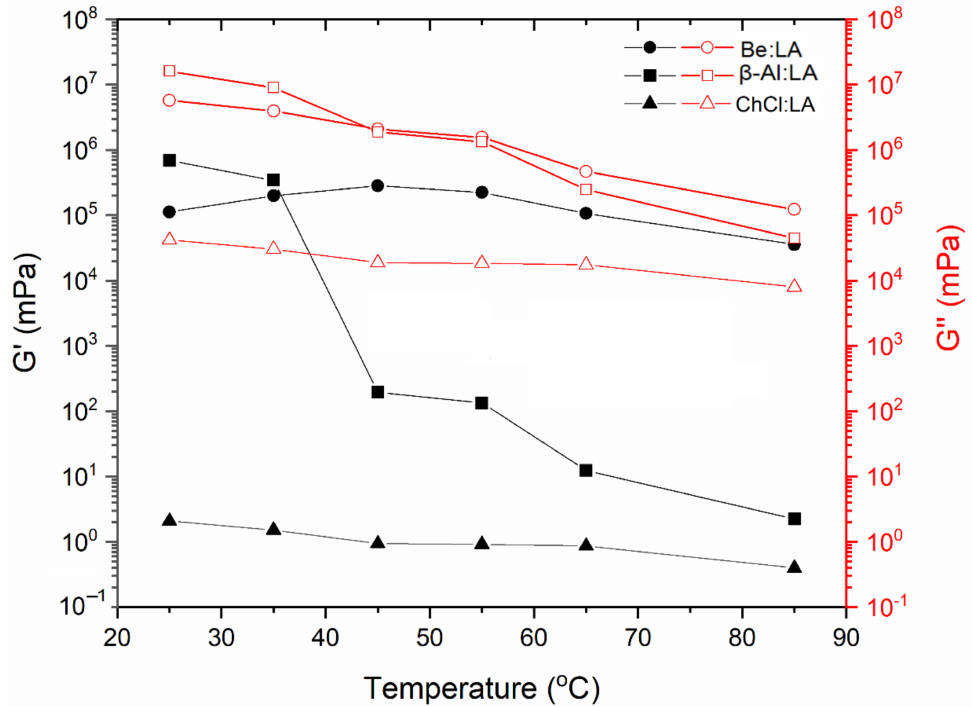
Figure 6. Effect of temperature on elastic modulus ( G (cid:48) ) and viscous modulus ( G” ) at a high angular frequency of 100 rad · s − 1 at temperatures from 25–85 ◦ C.